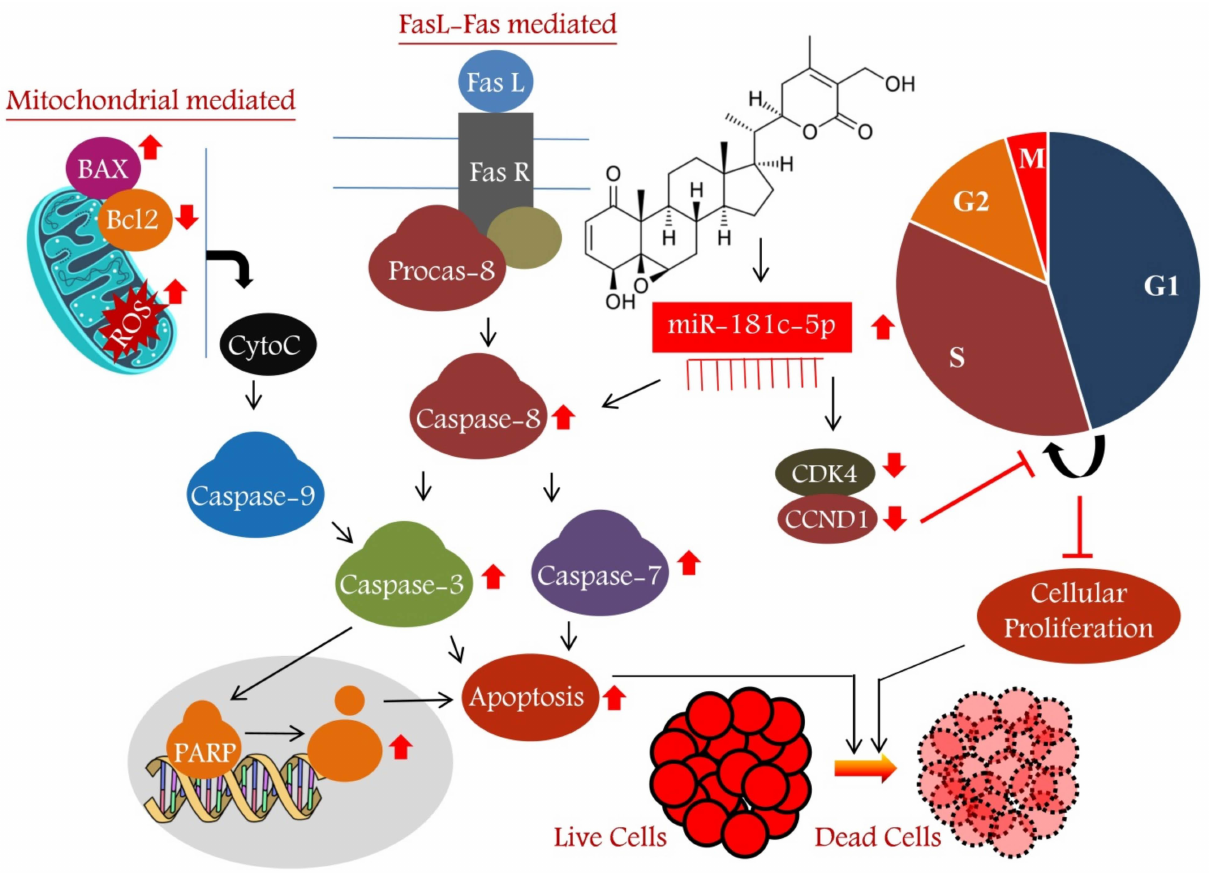
Figure 8. The microRNA-mediated anticancer mode of action of Withaferin A in triple-negative breast cancer cells. Withaferin A treatment increased miR-181c-5p expression, which reduces cellular proliferation and induces apoptosis in MDA-MB-231 cells. CytoC—Cytochrome C; Fas—Fas ligand; Fas R—Fas receptor; Procas—Procaspase; ROS—Reactive oxygen species; G2—G2 phase; M—M phase; G1—G1 phase; S—S